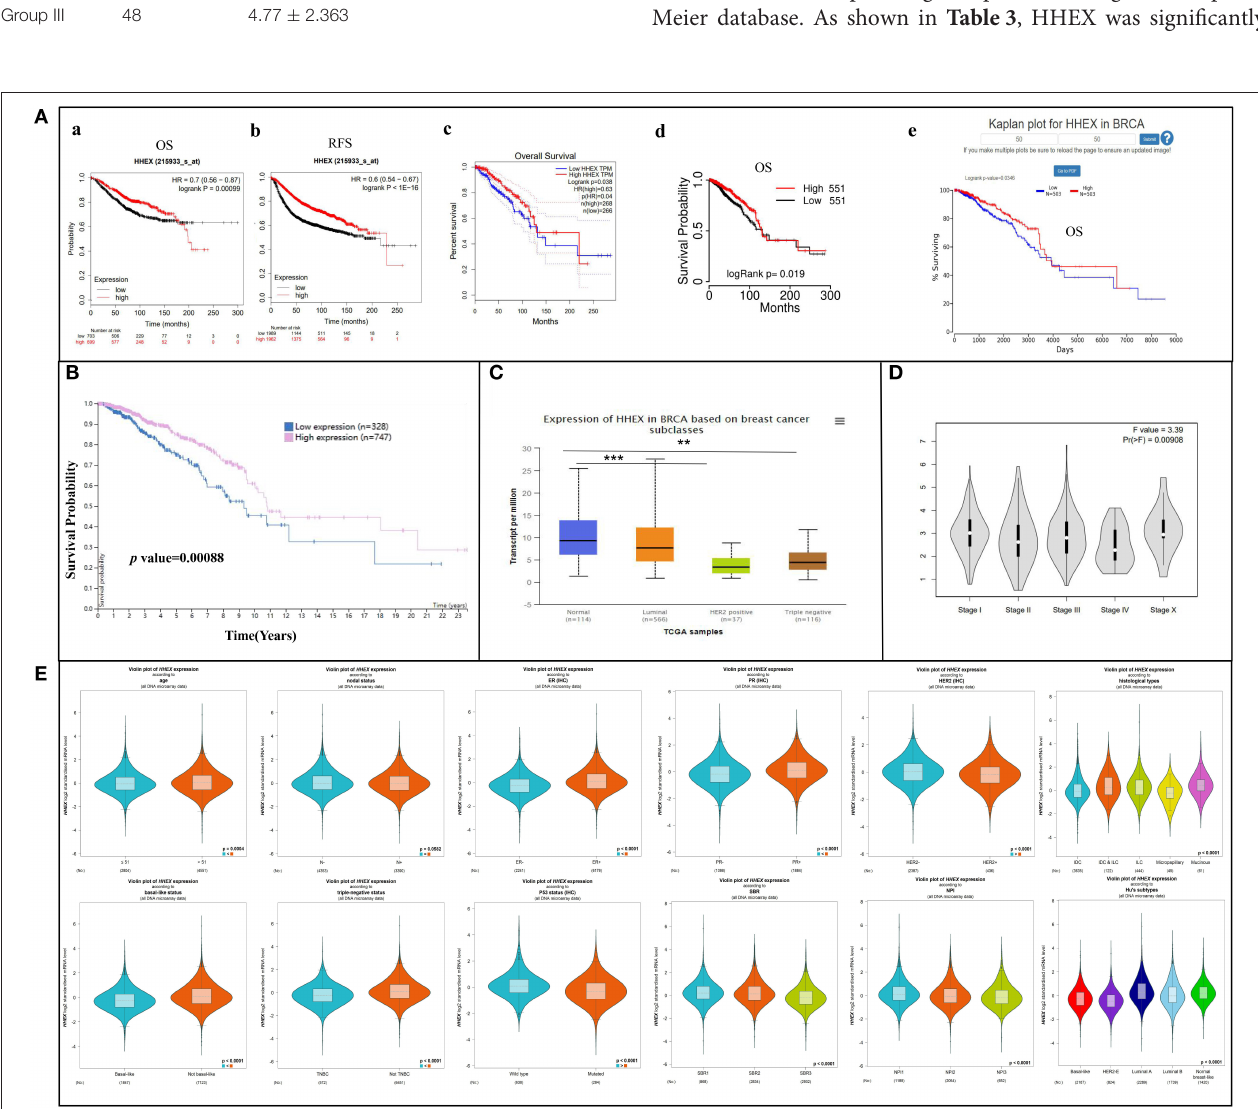
FIGURE 3 | Prognostic value of HHEX in breast cancer (BC) and relationship between HHEX and clinicopathological parameters of BC patients. (A) Kaplan–Meier plotter, GEPIA, TCGAportal, and OncoLnc reveal the prognostic value of HHEX in BC. (a) Kaplan–Meier plotter reveals the overall survival curves based on the mRNA level of HHEX in BC patients. (b) Kaplan–Meier plotter reveals relapse-free survival curves based on the mRNA level of HHEX in BC patients. (c) Overall survival curves of HHEX in BC patients determined using GEPIA. (d) Overall survival curves of HHEX in BC patients determined using TCGAportal. (e) Overall survival curves of HHEX in BC patients determined using OncoLnc. (B) Survival curves based on protein level of HHEX in BC patients determined using HPA. (C) Relationship between mRNA levels of HHEX with subclasses of BC determined using UALCAN. (D) Correlation between HHEX and the pathological stage of BC patients determined using GEPIA. (E) Relationship between mRNA levels of HHEX and clinicopathological parameters of BC patients determined using bc-GenExMiner. ** P < 0.05, *** P < 0.001.